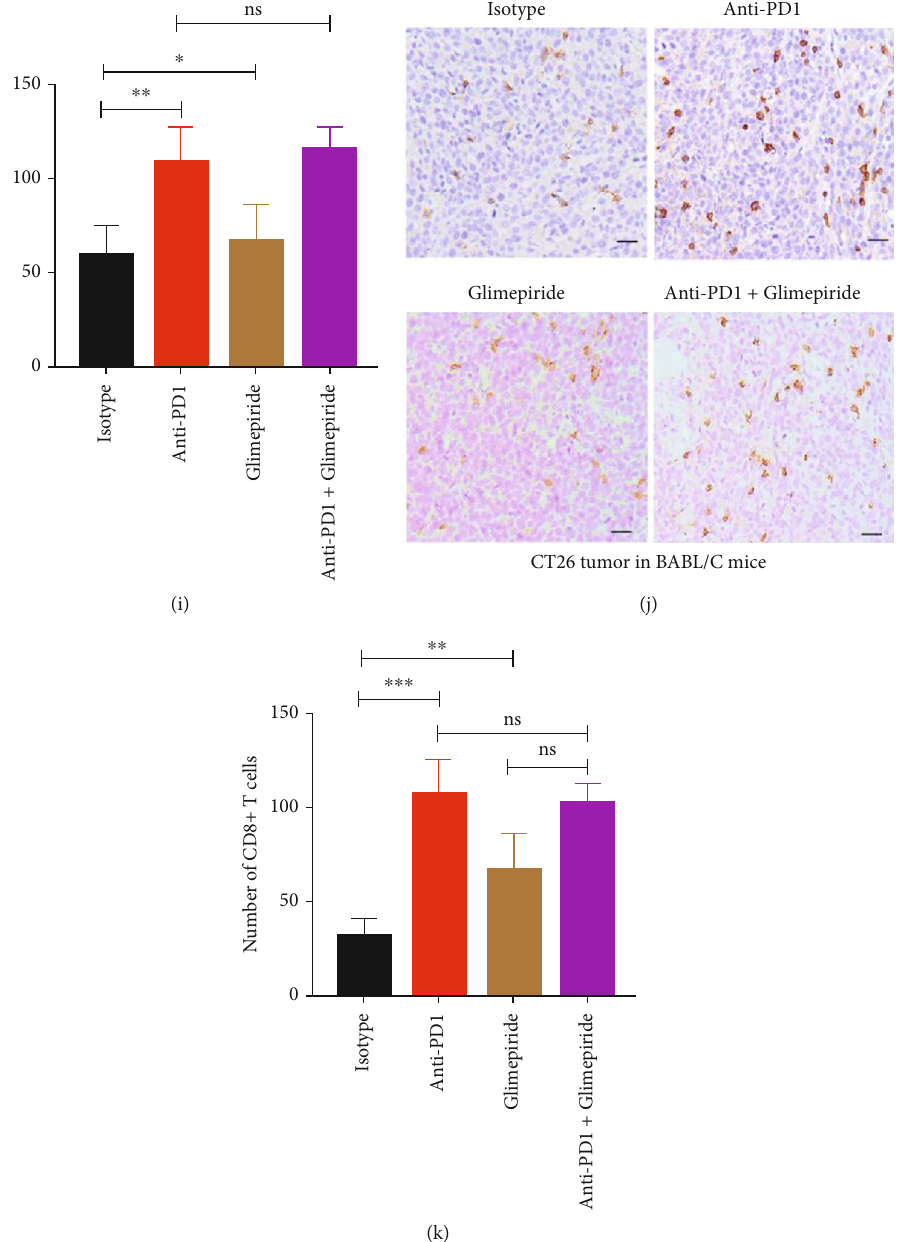
Figure 4: Glimepiride weakens colon tumor immune responses to anti-PD1. (a) Schematic overview of experimental design combined for (b) – (k). (b – d) Tumor growth (b) and weight (c) from MC38 tumor-bearing C57BL/6 mice were shown ( n = 7 ). (e – g) Tumor growth (e) and weight (g) from CT26 tumor-bearing on BABL/C mice were shown ( n = 7 ). (h and i) Sections from MC38 subcutaneous tumors were stained with anti-CD8 antibody by immunohistochemistry (h), and CD8 + T cells in fi ltration were analyzed in (i). (j and k) Sections from CT26 subcutaneous tumors were stained with anti-CD8 antibody by immunohistochemistry (j), and CD8 + T cells in fi ltration were analyzed in (k). Scale bars: 100 μ m. Data were analyzed by two-way ANOVA (b and e) and t -test (c, f, i, and k). ns: no signi fi cance; ∗ p < 0 : 05 , ∗∗ p < 0 : 01 , and ∗∗∗ p < 0 : 001 . Error bars denote for the e ff ect on the number of tumoral in fi ltrated CD8 + T cells, while insulin decreased the number of tumoral in fi ltrated CD8 + T cells (Figure S6E-H).